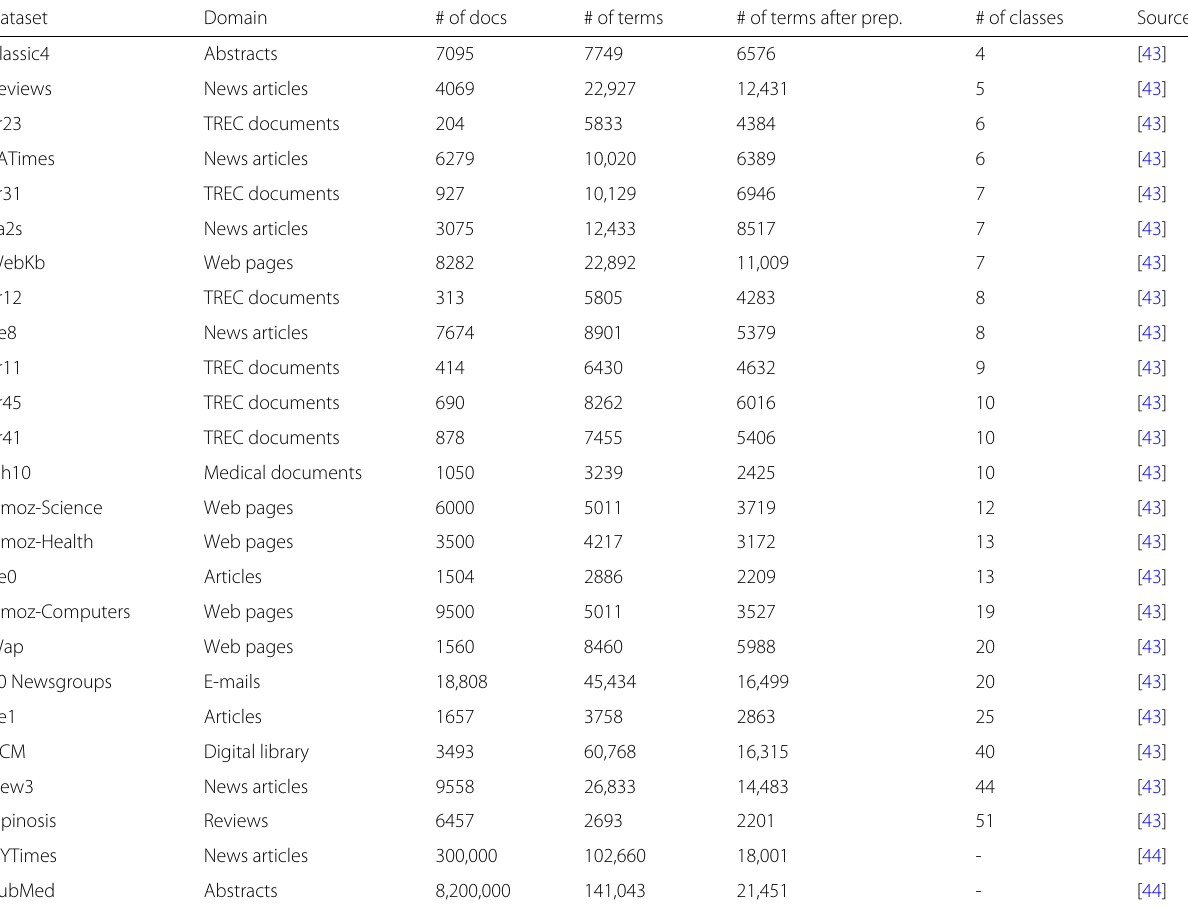
Table 1 Summary of datasets used to evaluate the hierarchical clustering algorithms